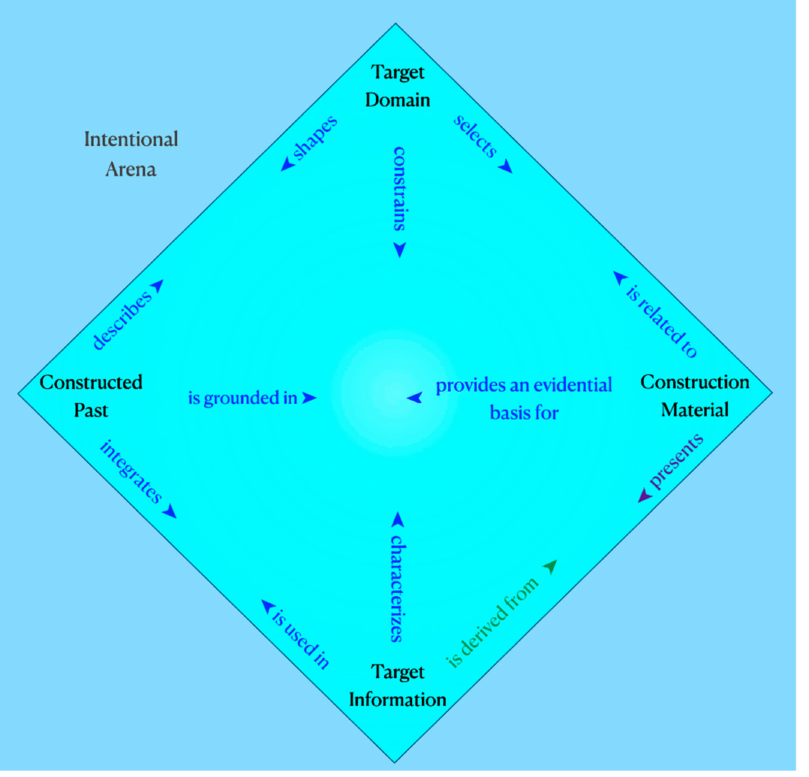
Figure 3. Construction of a Past, showing the main components of a construction (the Target Domain, Target Information, Construction Material, and Constructed Past) and their interrelationships. The Intentional Arena encompasses the four components as the Interpretive Context in which they are developed. The components are displayed within a diamond to indicate that the relationships are not discrete, but interrelated. The solid border of the diamond represents the Time